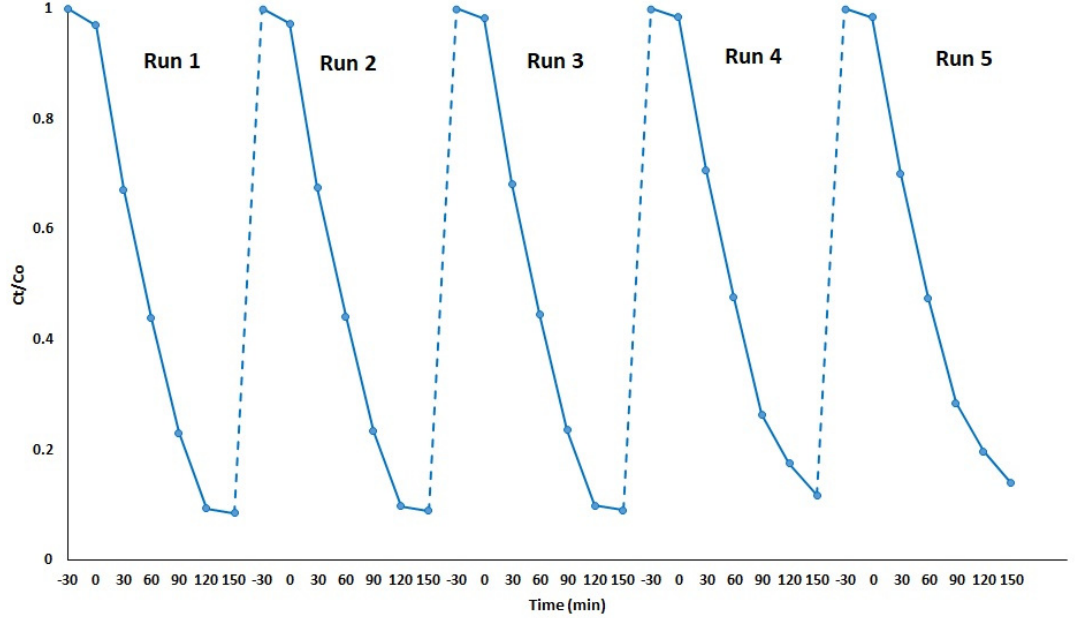
Figure 7. Recycling performance of electrospun nanofibers for photocatalytic degradation of methyl orange (MO) under simulated sunlight using PMMA: Ag 3 PO 4 /P25 (1:0.6).